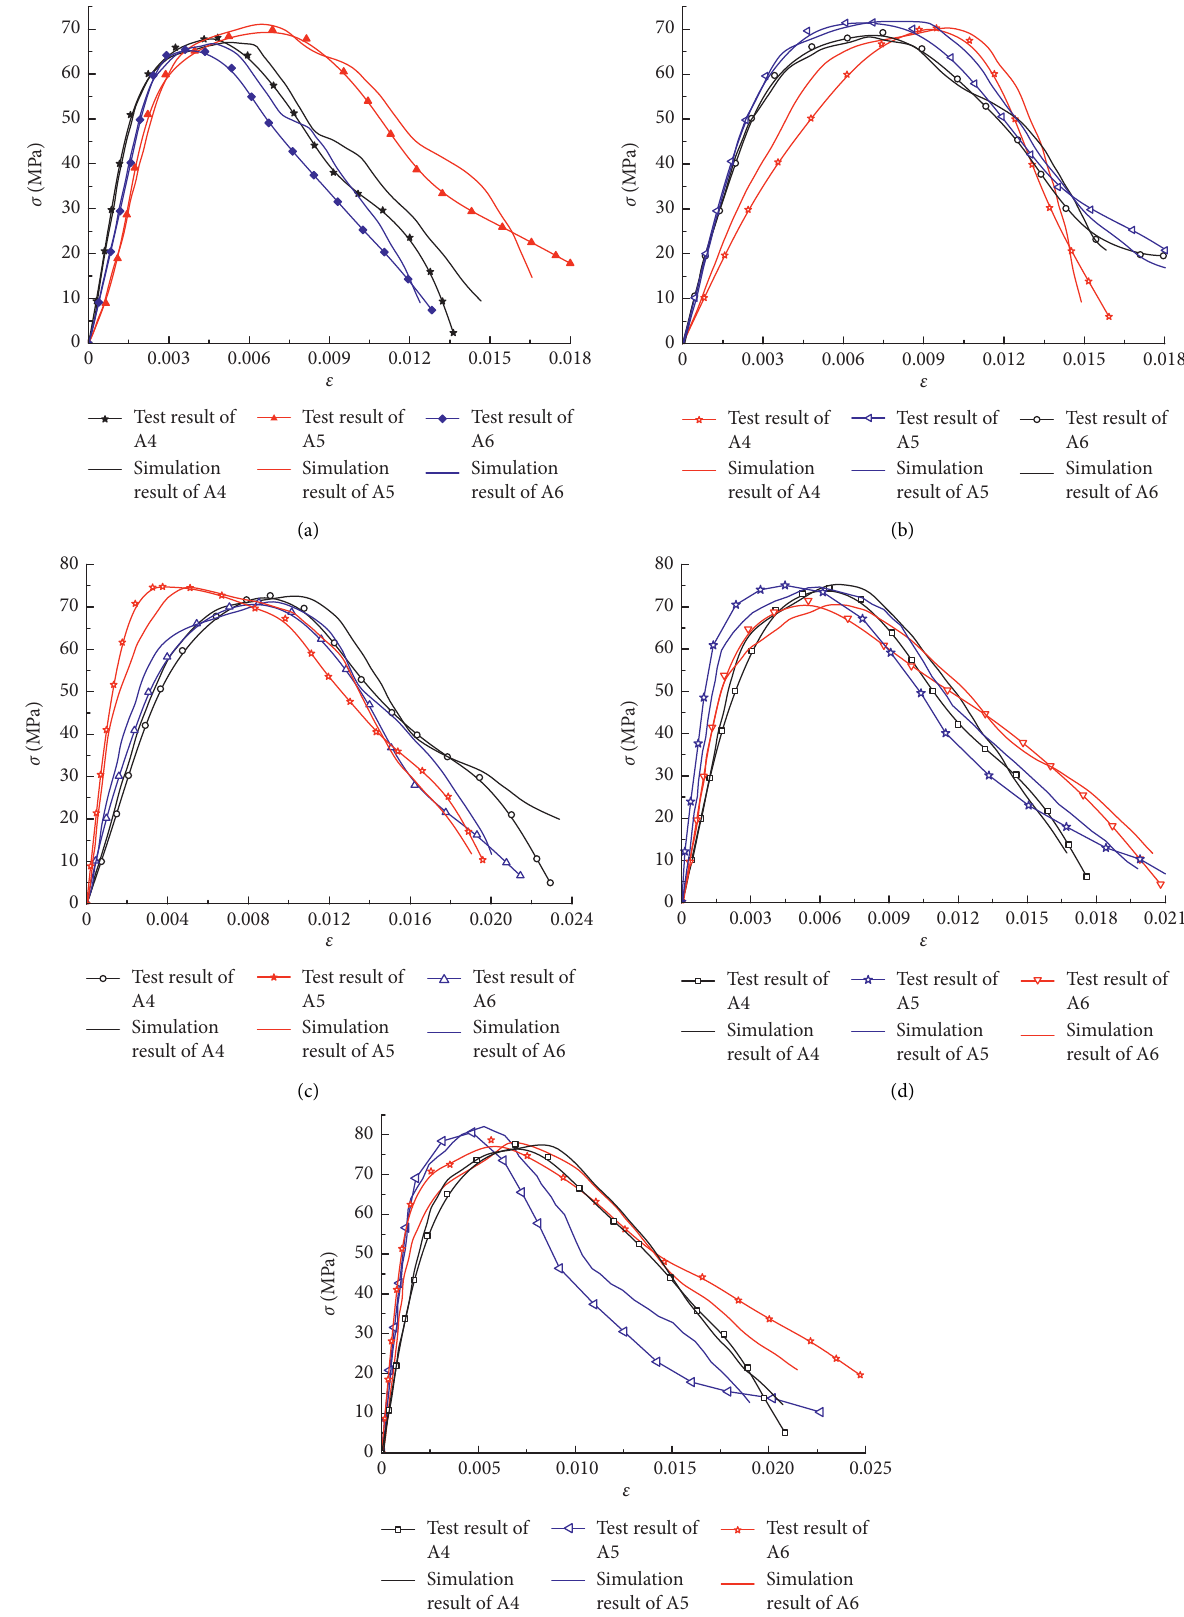
Figure 12: Comparison of stress-strain curves between test results and numerical simulation results: (a) 0.3MPa, (b) 0.35 MPa, (c) 0.4MPa, and (d)